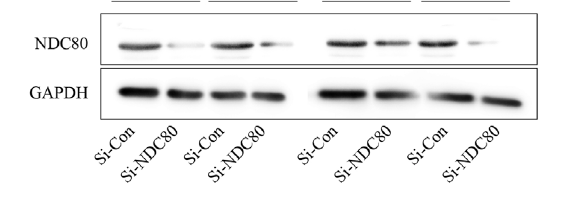
FIGURE 9 Si-NDC80 can inhibit the protein translation level of human glioblastoma cells and normal astrocytes NDC80. Western blotting detected NDC80 knockdown, NDC80 protein expression levels in human glioblastoma U251, U118, and A172 cell lines, and normal astrocyte cell line HA1800 were signi fi cantly